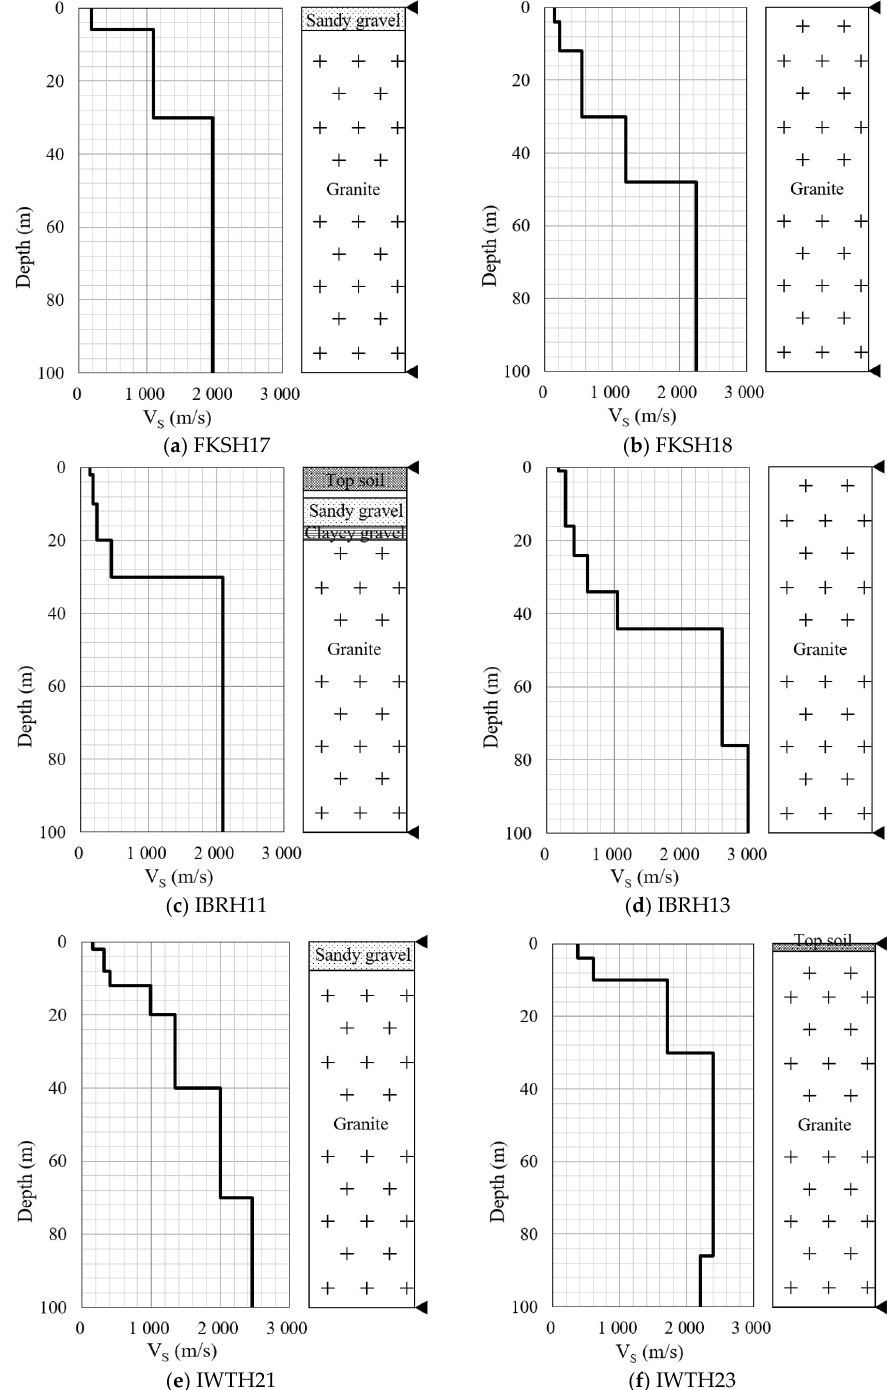
Figure 2. Soil profiles and shear wave velocities at the sites. In the seismic design, the ground stratum can be classified based on the shear wave velocity profile up to 30 m (100 ft) depth beneath the ground [18]. The average shear velocity ( V s, 30 ) is used for the classification and is calculated from Equation (1). The natural period of the soil deposit can theoretically be obtained from Equation (2) when the profile of shear wave velocity is available. The values of average shear velocities and natural periods for six sites are presented in Table 1. The table also includes the depths of the bedrock where the shear wave velocity ( V s ) exceeds 1000 and 2000 m/s, respectively. , = 30 (1) = 4 (2) where V s,30 is the shear wave velocity of the strata from the surface up to 30 m below the surface, T G is the natural period ( s ), n is the number of strata from the surface up to 30 m below the surface, H i is the thickness of stratum i ( m ), and V si is the shear wave velocity of stratum i ( m/s ). It is noted that the natural period can also be evaluated from the field measurements. For example, Nakamura [19] showed that the fundamental resonance frequency, which corresponds to the lowest amplification frequency, can be successfully determined by the horizontal-to-vertical spectral-ratio (HVSR) method, especially when a sharp velocity contrast is present at depth. Table 1. Average shear wave velocity and natural period for each station. Station